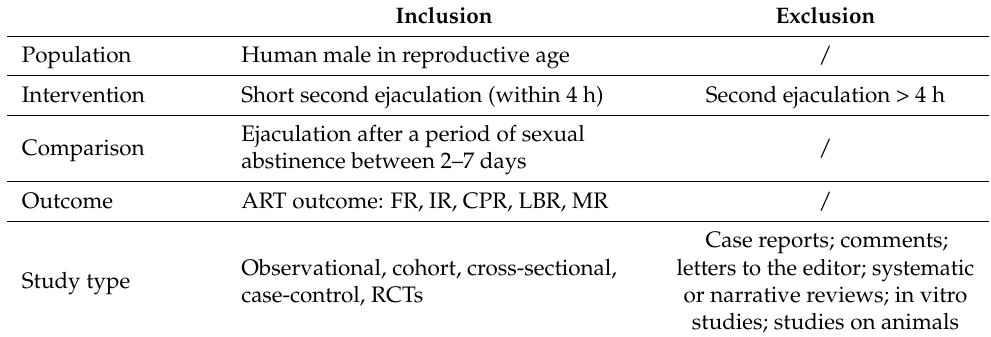
Table 1. PICOS (Population, Intervention, Comparison/Comparator, Outcomes, Study type) inclu- sion